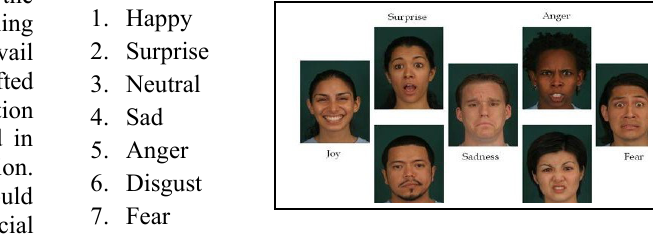
Fig 1. Basic Facial